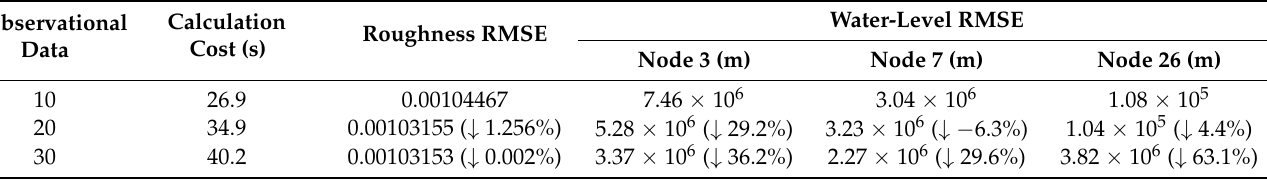
Table 2. Roughness RMSE and water-level RMSE at Nodes 3, 7 and 26 with different observational data. Observational Data